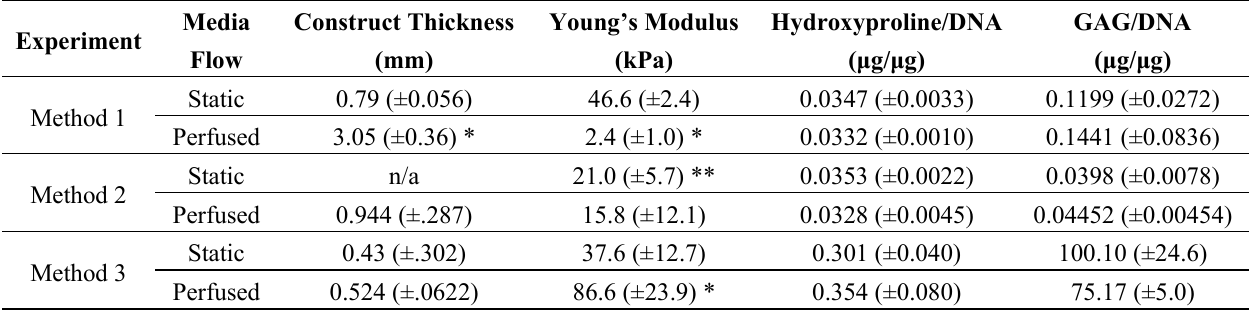
Table 1. Biochemical and biomechanical data of cartilage constructs from all experiments.